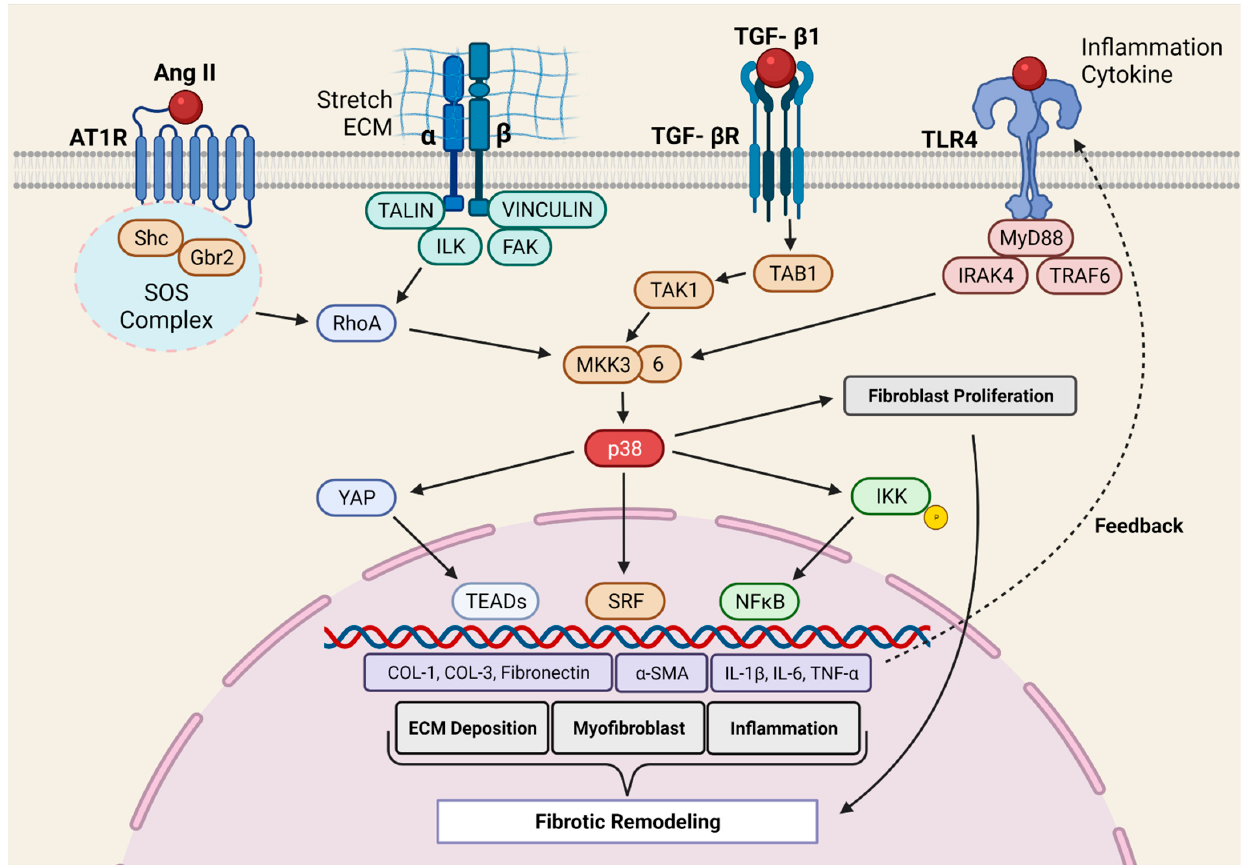
Figure 2. Molecular mechanism of p38 MAPK-mediated pro-fibrotic signaling. The p38 pathway is a critical positive regulator of myocardial fibrosis. At the receptor level, p38 signaling is activated by a variety of stimuli, including Ang II (AT1R), mechanical sensing (integrins), and inflammatory cytokines (TGF- β R, TLR4). These membrane-proximal events lead to the activation of MKK3/6, the specific upstream activator of the p38 MAPK kinases. Once activated, p38 crosstalk with IKK-NFkB signaling and Hippo effector YAP to mediate the pro-fibrotic (Col-1, Col-3, FN, and α -SMA) and pro-inflammatory (Il-1b, IL-6, TNF- α ) gene programs. Ang II = Angiotensin II; α -SMA = Alpha-smooth muscle actin; AT1R = Angiotensin II receptor; Col = Collagen; ECM = Extracellular Matrix; FAK = Focal adhesion kinase; GBR2 = Growth factor receptor-bound protein 2; IKK = I κ B kinase; IL = Interleukin; ILK = Integrin-linked kinase; IRAK4 = Interleukin 1 receptor-associated kinase 1; MKK = Mitogen-activated protein kinase kinase; MyD88 = Myeloid differentiation factor 88; NFkB = Nuclear factor κ B; RhoA = Ras homolog family member A; Shc = SH2-containing collagen-related proteins; SOS complex = Son of sevenless guanine nucleotide exchange factor; SRF = Serum response factor; TAB1 = TAK binding protein 1; TAK1 = TGF- β -activated kinase 1; TEAD = TEA domain family member; TGF- β 1 = Transforming growth factor beta 1; TGF- β R = TGF- β receptor; TLR4 = Toll-like receptor 4; TNF- α = TNF, tumor necrosis factor α ; TRAF6 = TNF receptor-associated factor; YAP 1 = Yes-associated protein